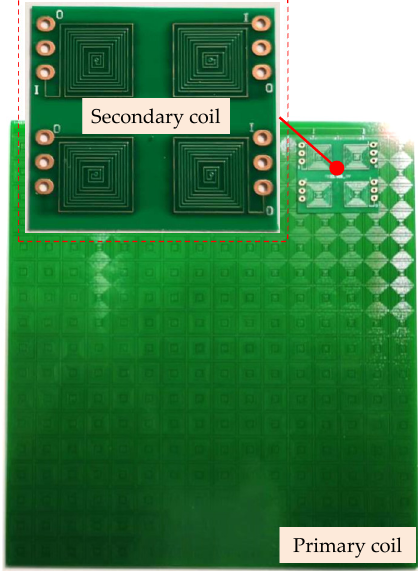
Figure 9. The Sensor prototype.